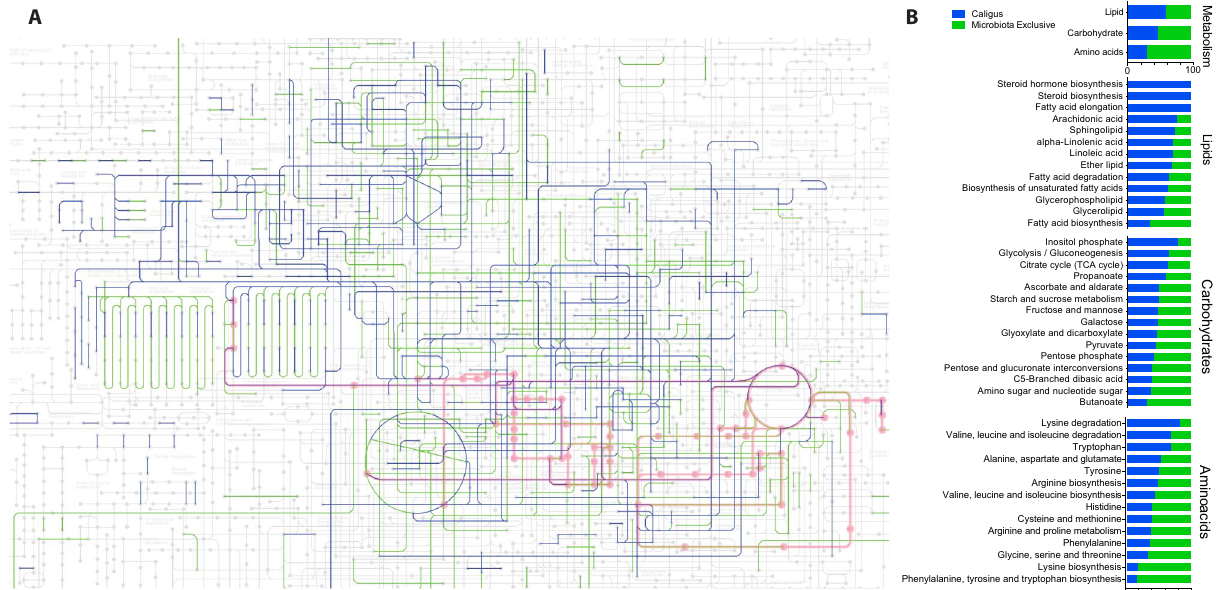
Figure 3. ( A ) Graphical representation of the metabolic pathways reconstructed for Caligus rogercresseyi (blue) and its associated microbiome (green). The amino acid metabolism is highlighted in red. ( B ) Percentage of genes annotated for the different metabolic pathways encoded in the sea lice genome (blue) and that were exclusively encoded in the microbiome (green). All pathways were constructed using KEGG pathways as reference 66